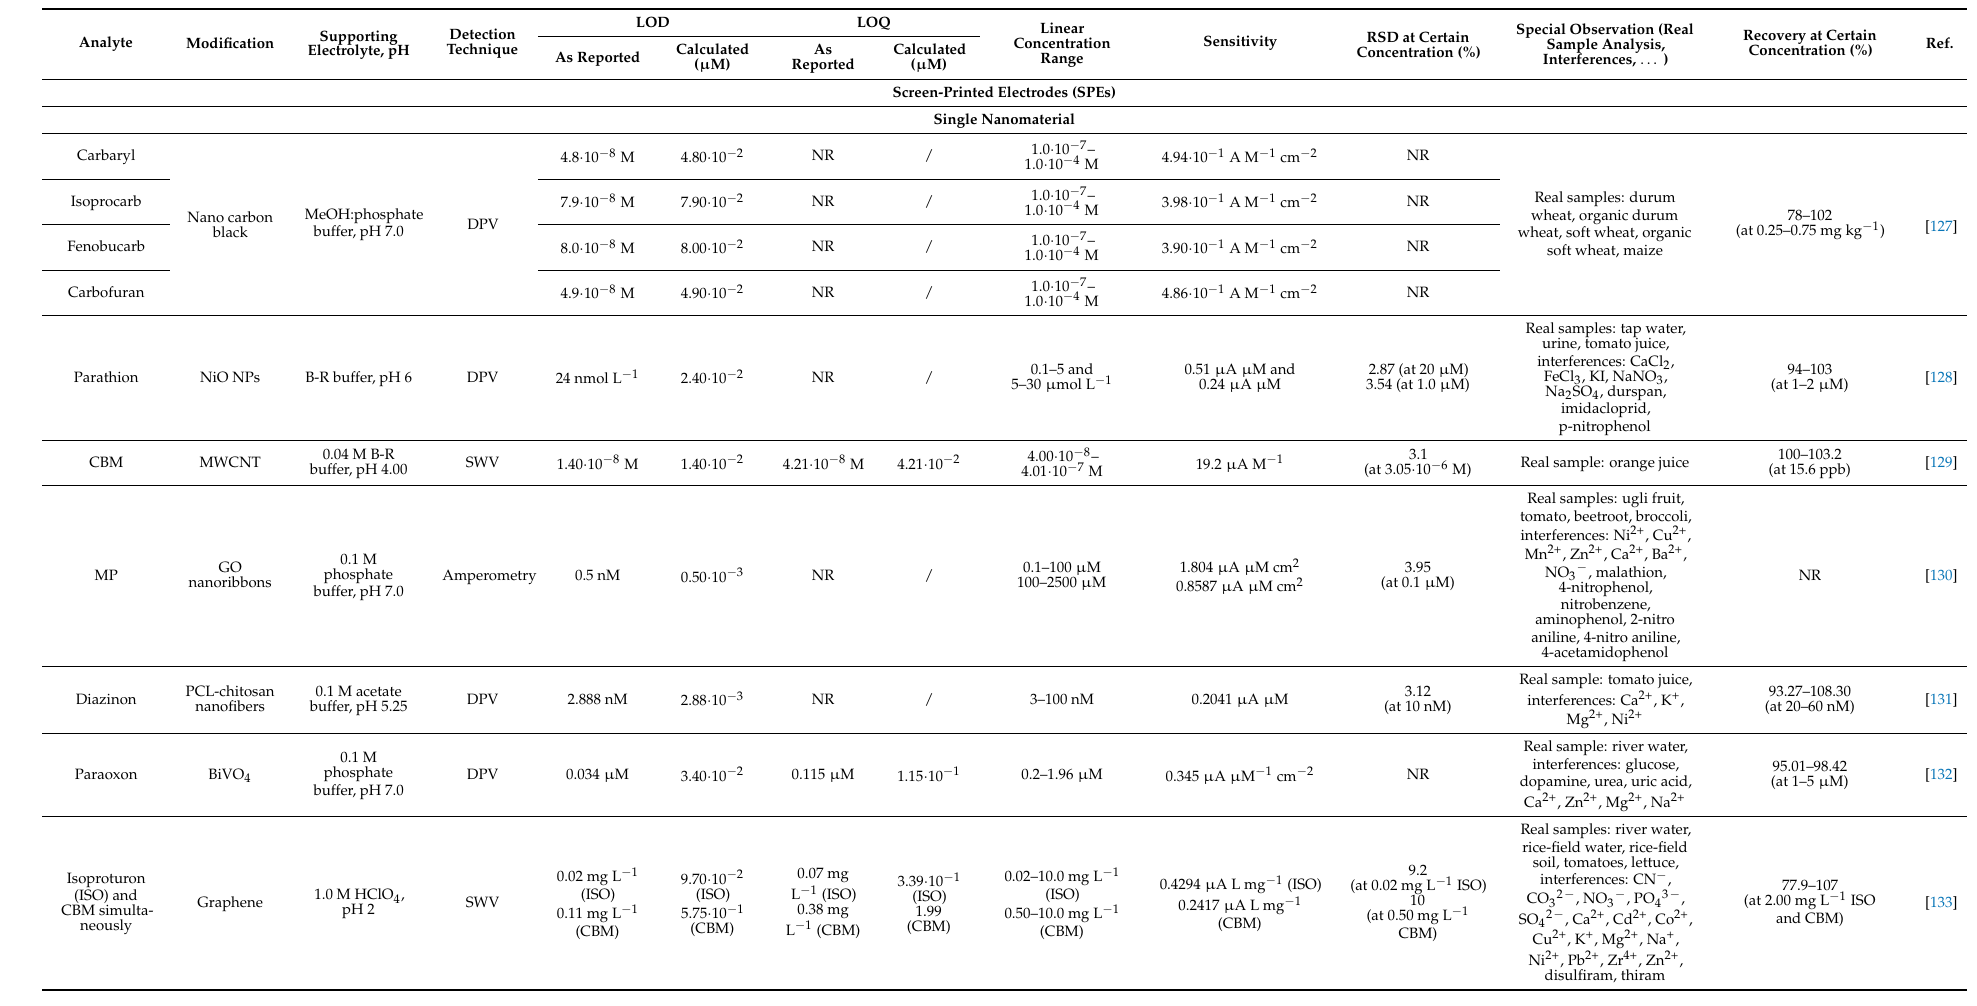
Table 3. Data of recently reported electrochemical sensors for non-enzymatic pesticide detection using modified screen-printed electrodes